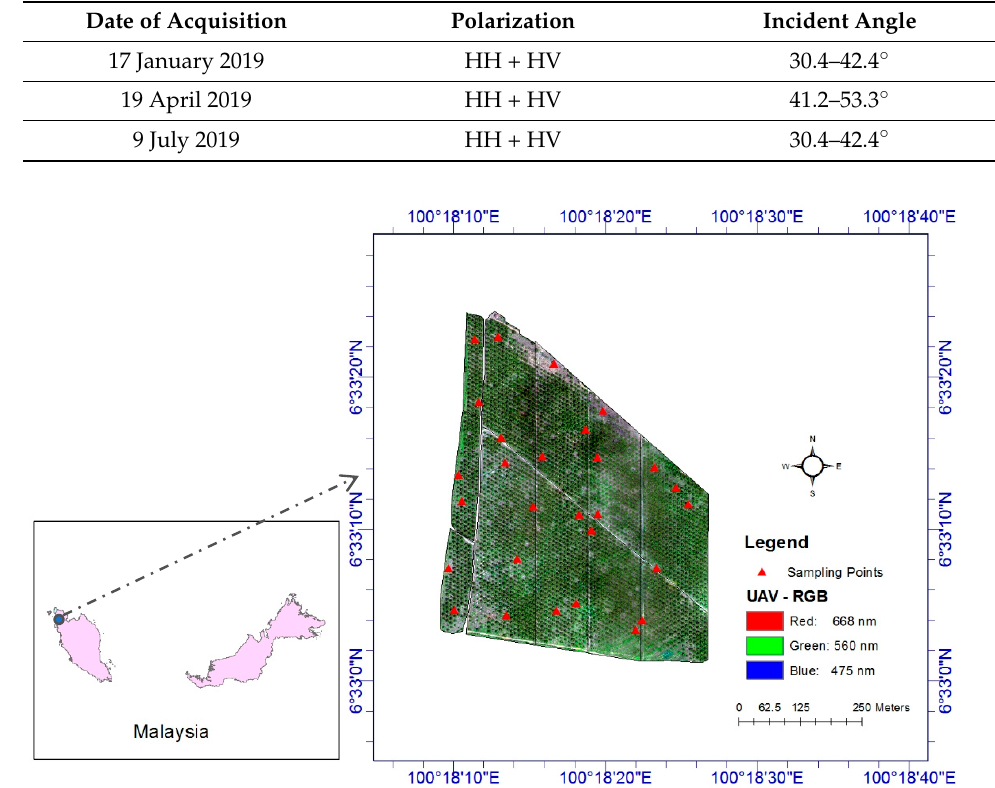
Figure 1. Oil palm cultivation area in Chuping, Perlis State, Malaysia.